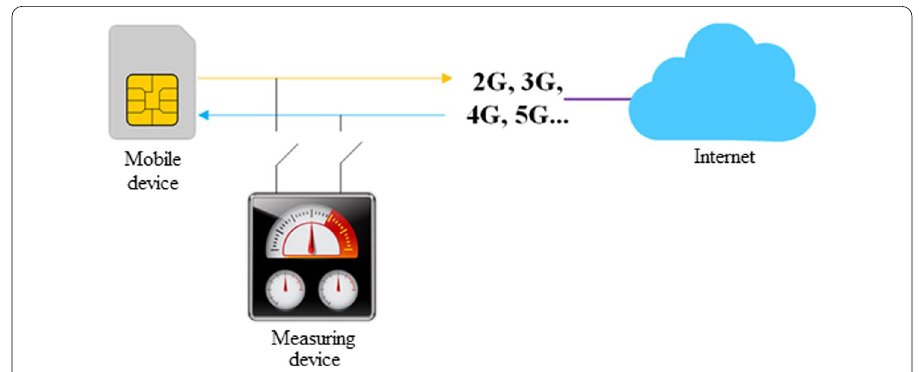
Fig. 7 Simplified network